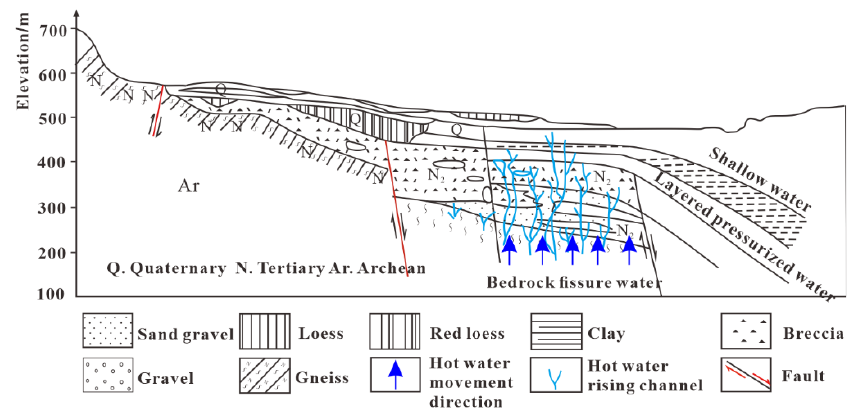
Figure 2. Geological profile of the aquifer (modified from [8]).